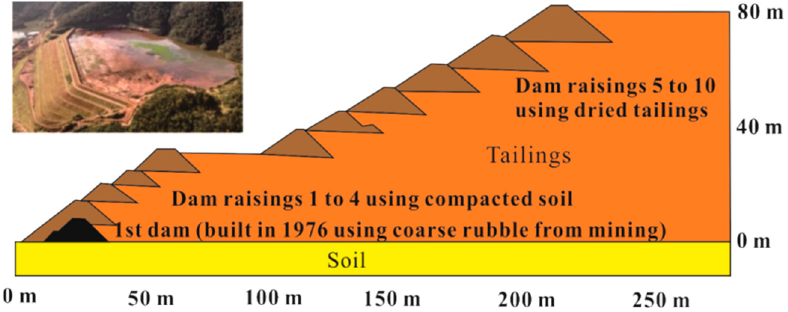
Figure 12. Cross section of Brumadinho dam "Barragem I" from the west to the east [88,89].